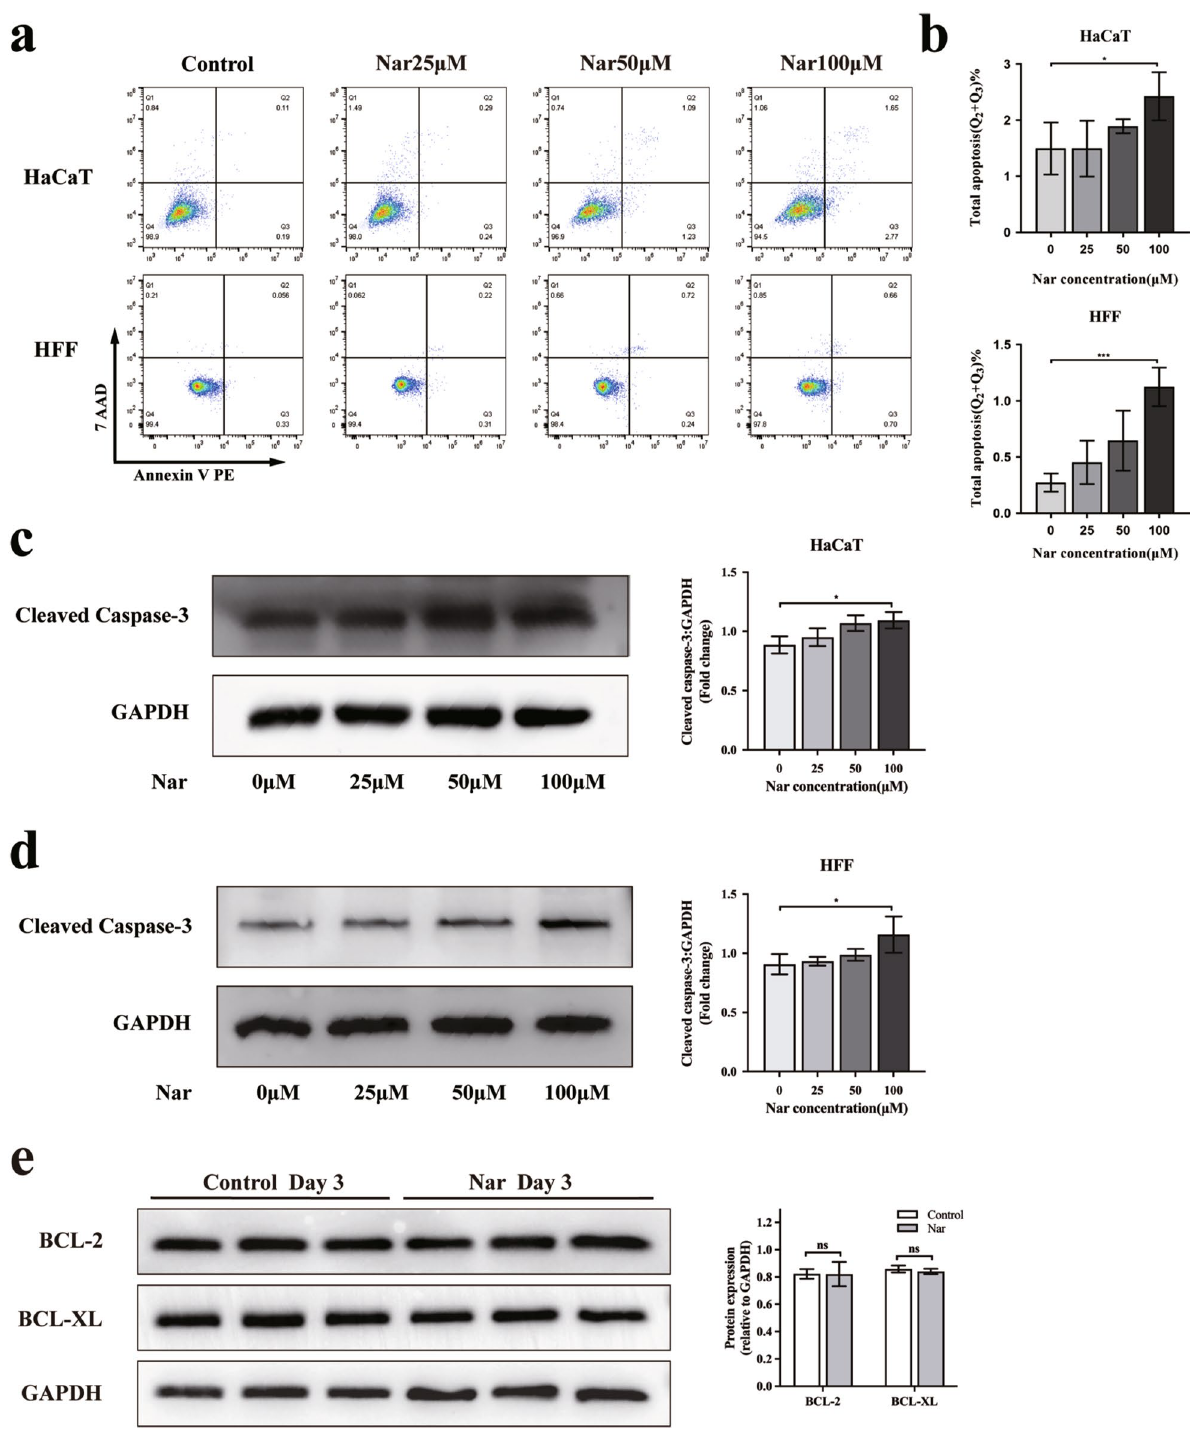
Figure 7. Effect of naringenin on cell apoptosis. HaCaT cells and HFFs were treated with naringenin for 3 h. ( a ) HaCaT cells and HFFs were stained with PE-conjugated Annexin V and 7-AAD, and the apoptosis rate ( b ) of cells was analysed. Representative Western blots showing the changes in cleaved caspase 3 protein expression in HaCaT cells( c ) and HFFs( d ) normalized to GAPDH. ( f ) Representative bands of BCL-2, BCL-XL protein levels in the wound tissue of mice on day 3 were detected by Western blotting. Original blots are presented in Supplementary Fig. 4. For all studies n ≥ 3. Error bars show the means ± SDs. Bar chart data were compared by ANOVA. * P < 0.05, ** P < 0.01, *** P < 0.001, and **** P <